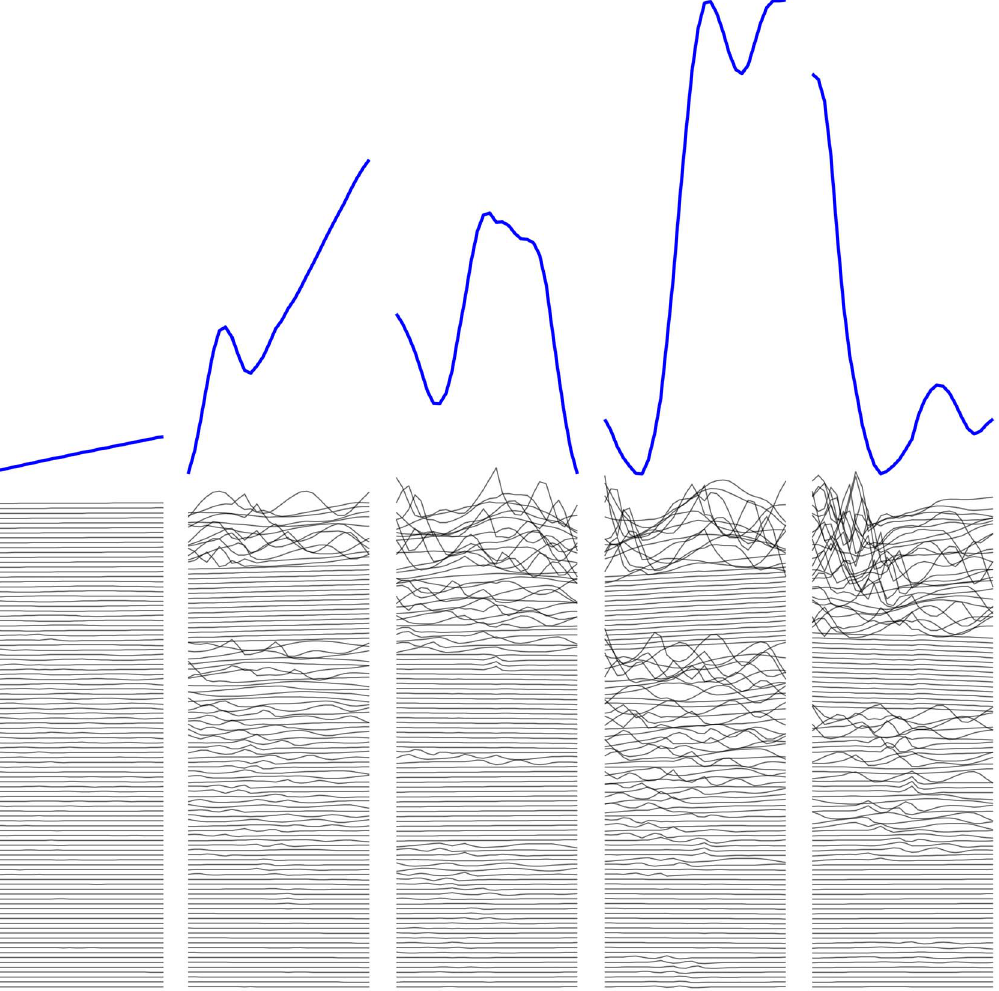
Figure 4. Learned features form a distributed representation and interact via constructive and destructive interference. The interference, as well as the autoencoder’s use of ramp detectors in blocks, are manifest in the confluence of features of this waterfall display. Thick blue lines: selected reconstructions of 30-day patches from the top panel in Figure 1. Stacked thin black lines: all 100 first-layer features, scaled and sorted by the magnitude of their contribution to the reconstruction.